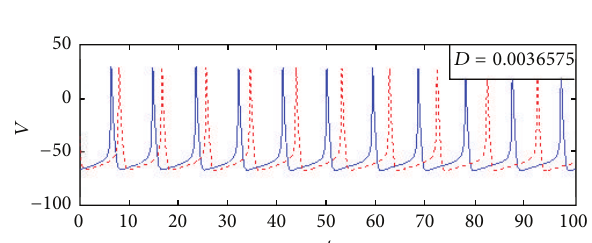
Figure 15: Membrane potential of two coupled MCs when 𝑔 0 .